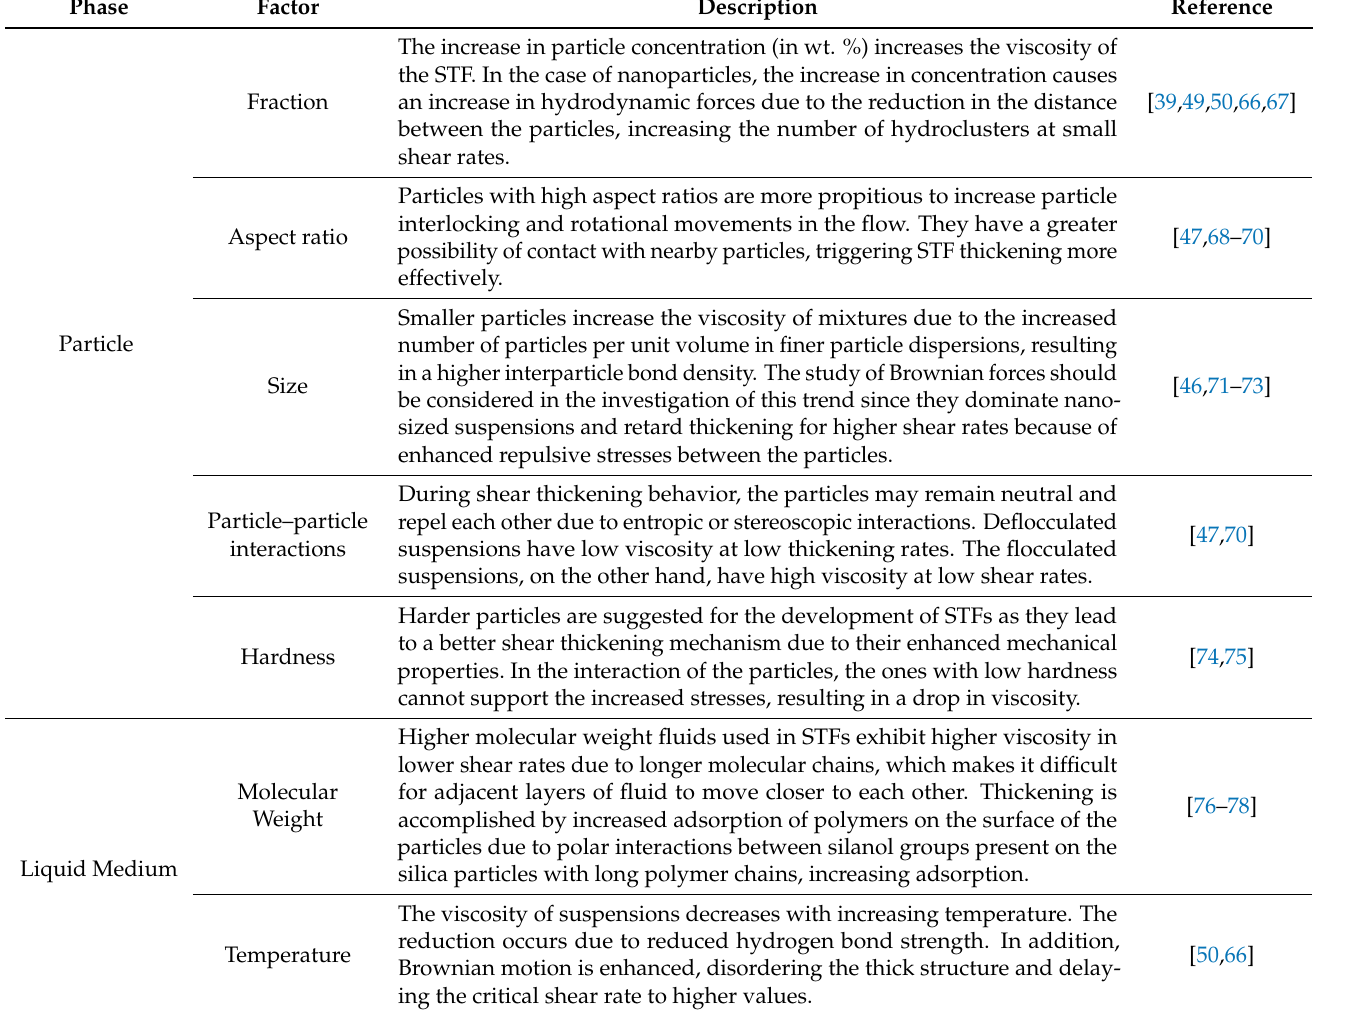
Table 3. Summary of factors influencing the rheological properties of shear thickening